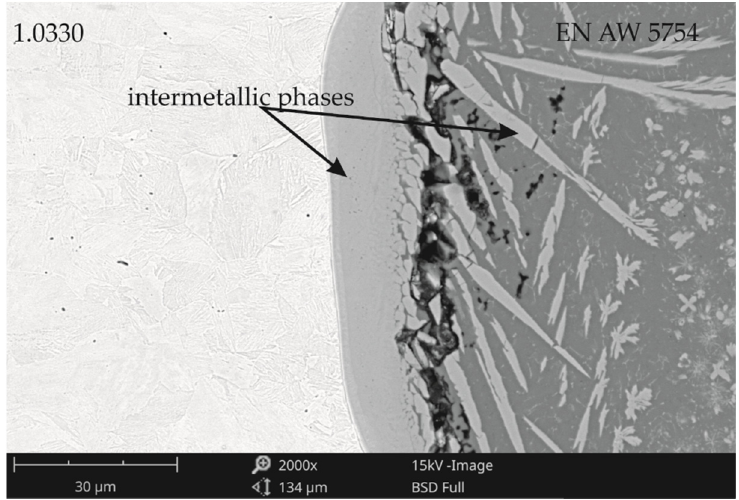
Figure 17. Scanning electron microscope image of the intermetallic phases.